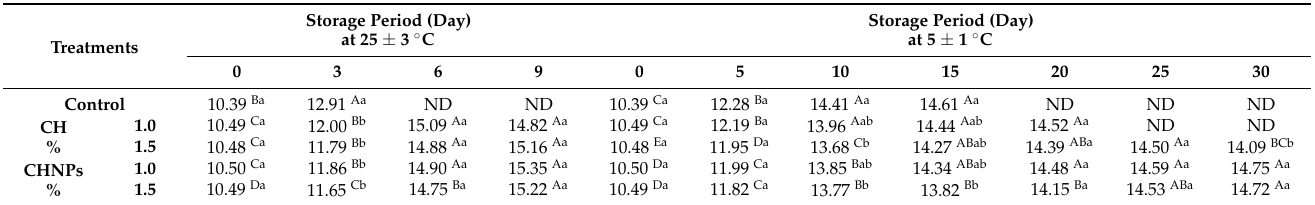
Mean values in the same row (as a capital letter) or column (as a small letter) with different letters are significantly different ( p < 0.05). ND: not determined. For each parameter (row), different capital letters (A, B, C, D, E) in superscript indicate significant differences at p < 0.05 among storage treatments. For each column, different small letters (a, b) in superscript indicate significant differences at p < 0.05 among treatments for each measured parameter.